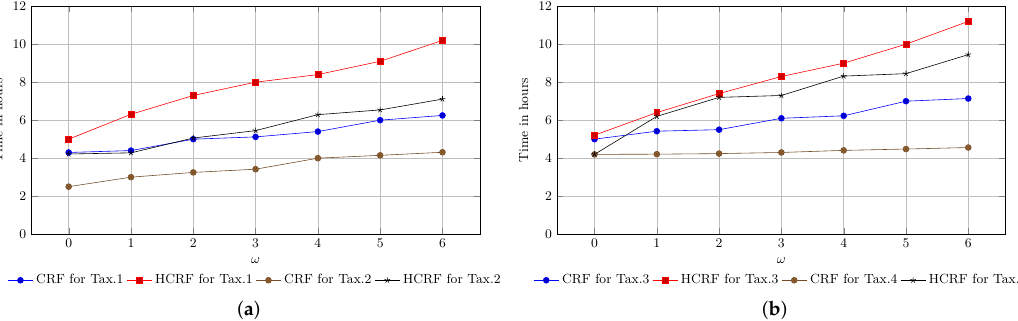
Figure 9. CRF and HCRF training cost in terms of time: ( a ) training cost of CRF and HCRF for Tax.1 and Tax.2; ( b ) training cost of CRF and HCRF for Tax.3 and